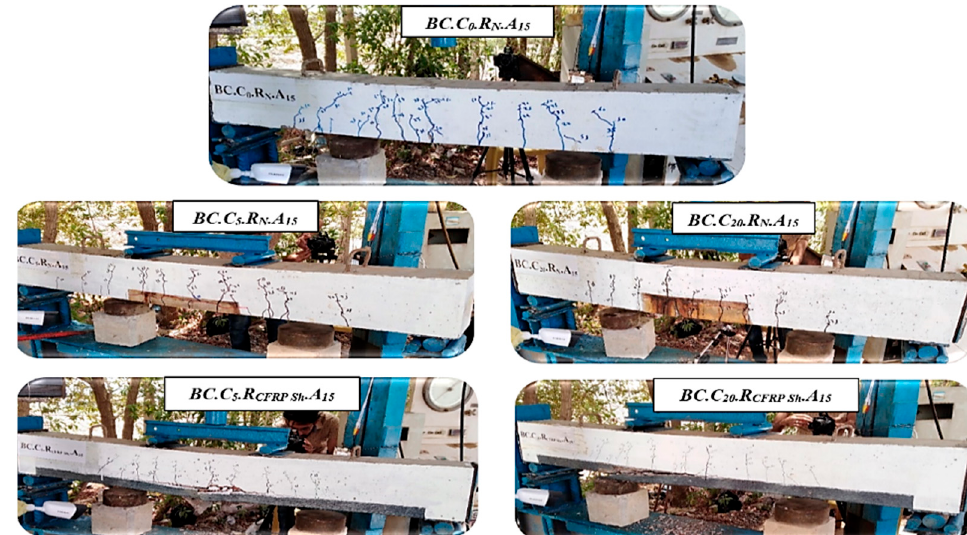
Figure 6. Cracks pattern at failure for specimens in group A.